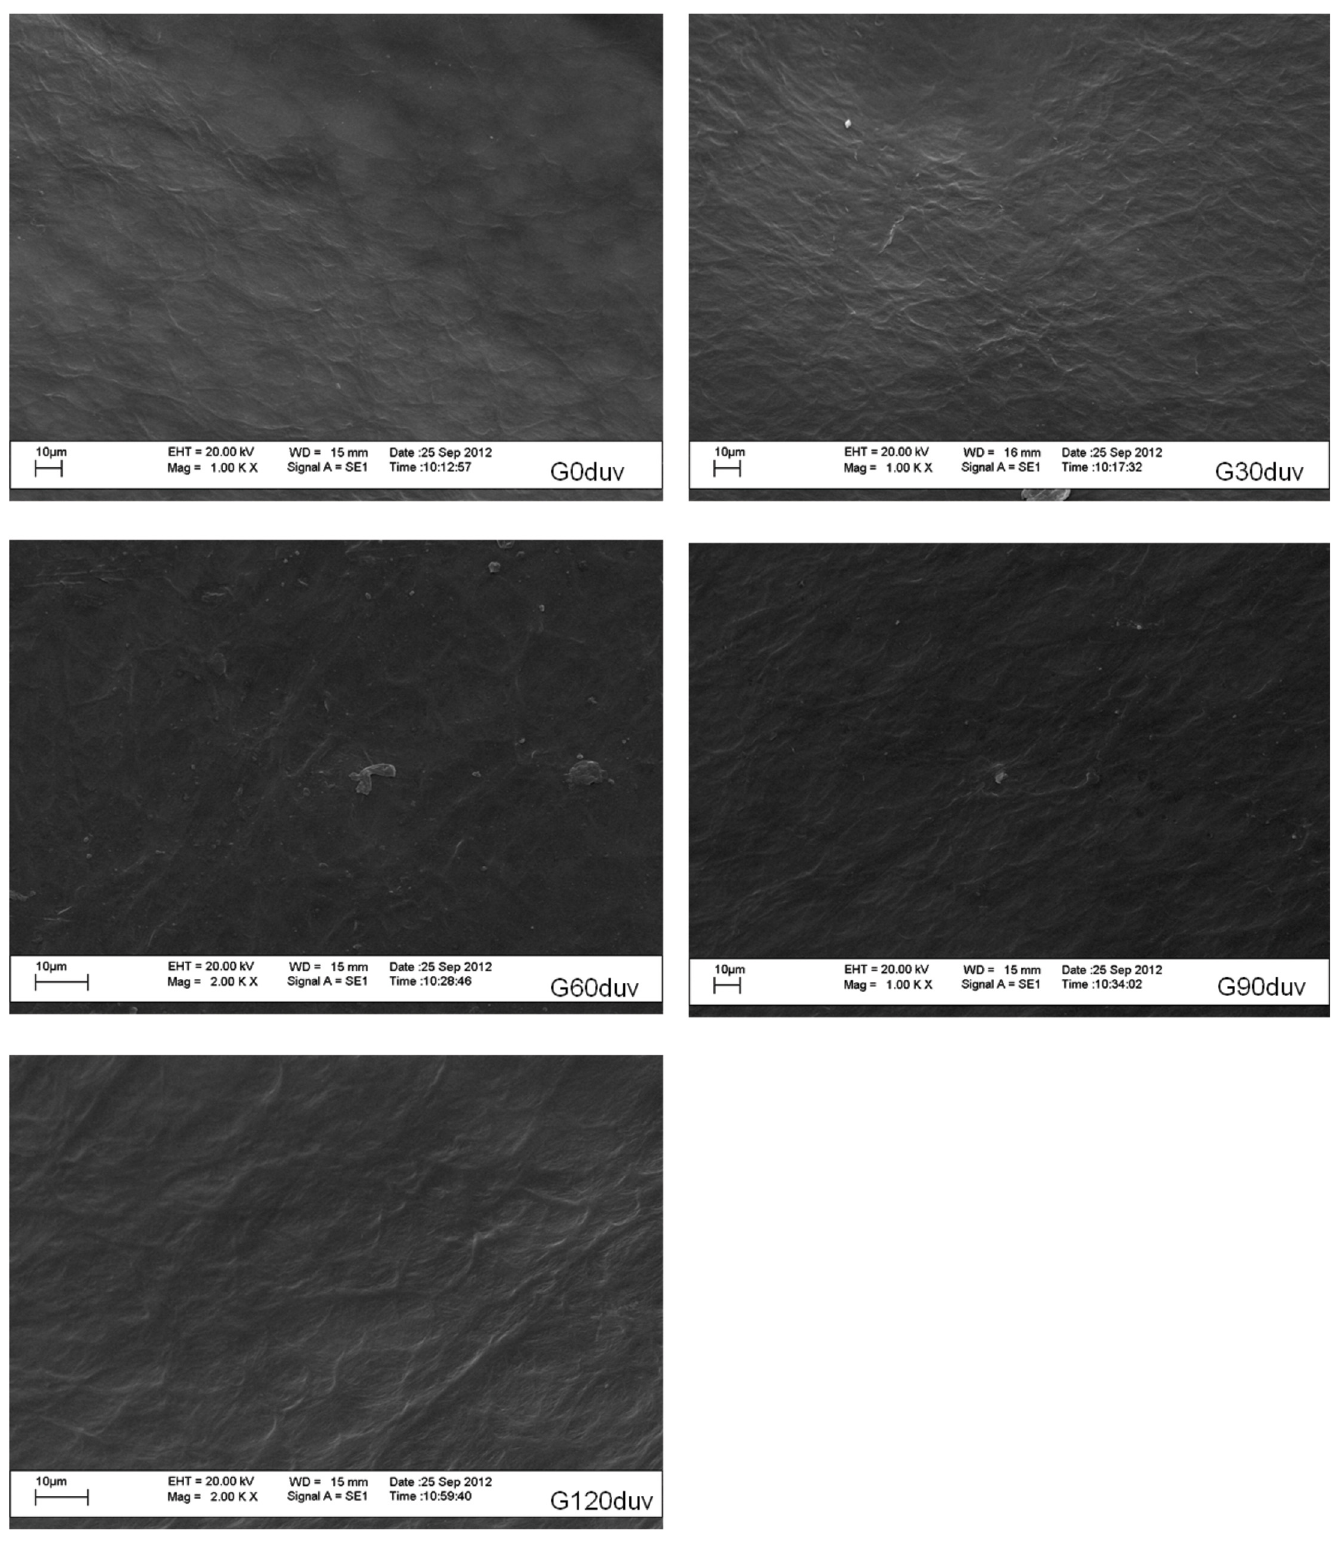
Fig 2. Scanning electron micrography of green polyethylene surface before (G0duv) and after 30 d (G30duv), 60 d (G60duv), 90 d (G90duv) or 120 d (G120duv) of exposure to sunlight. Note the absence of any expressive modification in the plastic surface due to sunlight exposure.